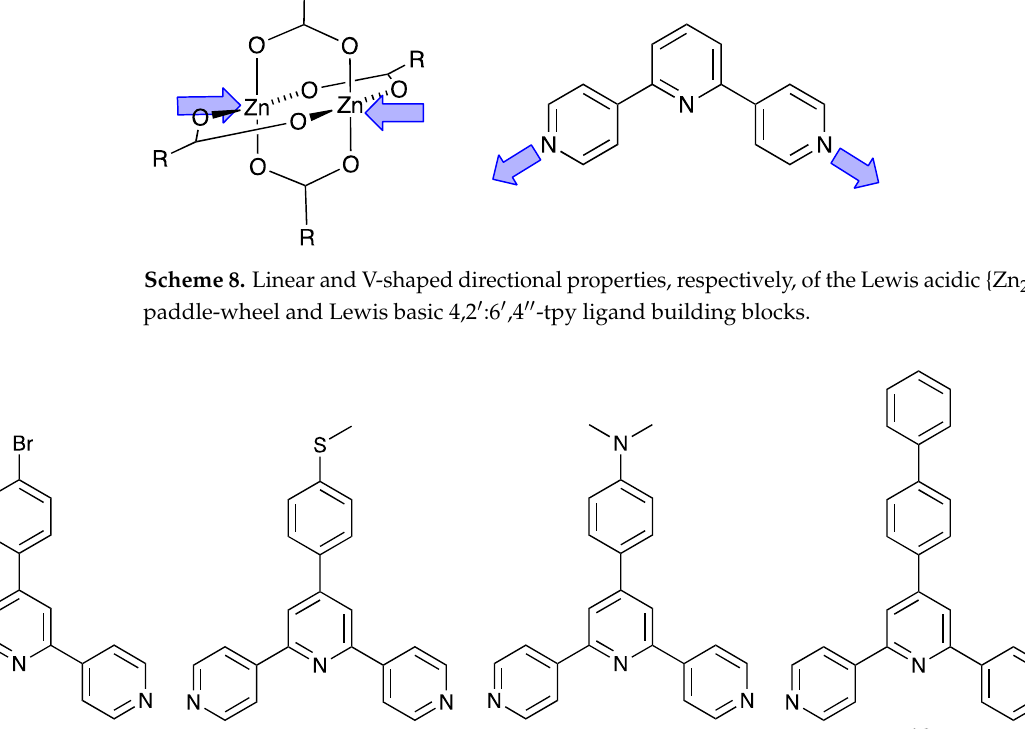
Figure 15. Part of the 1D ‐ zigzag coordination polymer chain in [Zn 2 ( μ‐ OAc) 4 (4’ ‐ (4 ‐ BrC 6 H 4 ) ‐ 4,2’:6’,4” ‐ tpy)] n (CSD refcode CUXCOO) and a space ‐ filling representation of parts of two adjacent chains showing packing to form 2D ‐ layers. The defined N...N distance gives a measure of the separation between chains in a given layer (see text). A zigzag polymer is also assembled when ligand 30 reacts with zinc(II) acetate under conditions of crystal growth by layering. In [Zn 2 ( μ‐ OAc) 4 ( 30 )] n , (CSD refcode RIJFUN), face ‐ to ‐ face π‐ stacking of both pairs of biphenyl domains and pairs of 4,2’:6’,4” ‐ tpy units contribute to packing interactions [62]. The zigzag chains are arranged into 2D ‐ sheets in a similar manner to the chains in polymers containing 14 , 27 , 28 , and 29 , but the greater steric demands of the biphenyl unit force the chains further apart. The N...N distance de ‐ fined in Figure 15 is 16.151 Å in [Zn 2 ( μ‐ OAc) 4 ( 30 )] n , and this compares to 15.294, 15.077, 14.902 and 14.898 Å in the assemblies with 14 , 27 , 28 and 29 . While the mode of packing of chains into 2D ‐ sheets remains the same in [Zn 2 ( μ‐ OAc) 4 (4’ ‐ X ‐ 4,2’:6’,4” ‐ tpy)] n assemblies with 4’ ‐ X ‐ 4,2’:6’,4” ‐ tpy = 14 , 27 , 28 , 29 , and 30 , the different substituents influence the ar ‐ rangement of the layers with respect to one another (as exemplified in Figure 16) in order to optimize packing interactions. Note that the solvent ‐ accessible void space is small, and within this series, only [Zn 2 ( μ‐ OAc) 4 ( 14 )] n . 0.3 n CH 2 Cl 2 with the 4’ ‐ phenyl substituent in ligand 14 incorporates solvent.